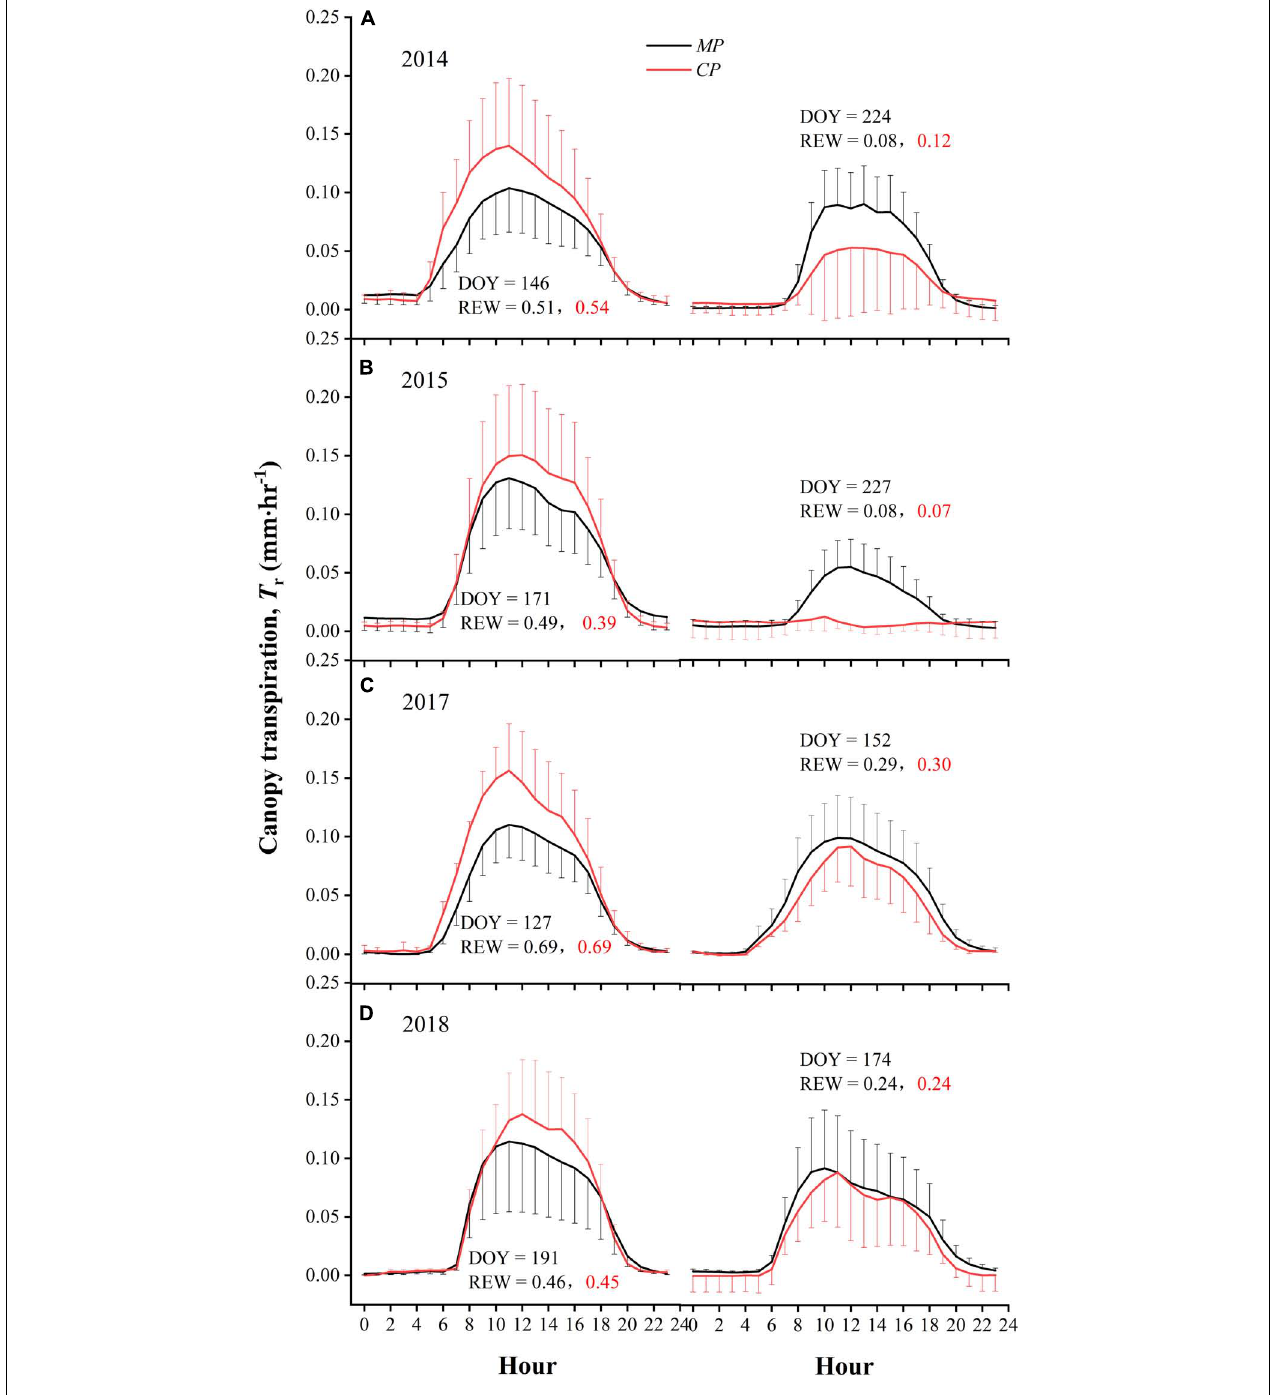
FIGURE 8 | Comparison of diurnal patterns of canopy transpiration, T r on two typical sunny days with very different relative extractable soil water (REW) values in 2014 (A) , 2015 (B) , 2017 (C) , and 2018 (D) of measurement.